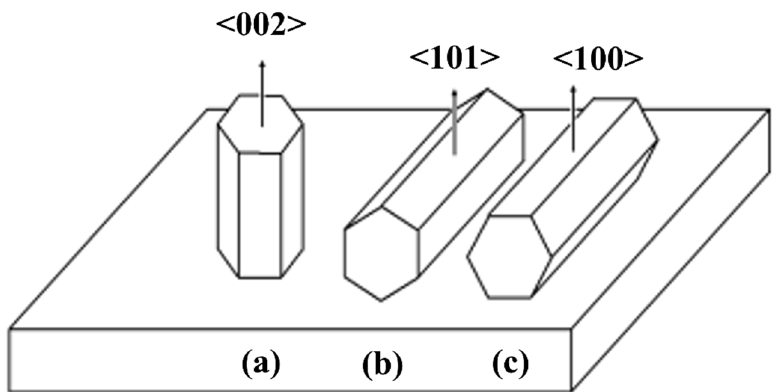
Figure 7. Schematic diagram of the relationship between microstructure and crystal growth orientation of ZnO: ( a ) a columned structure of c ‐ axis growth perpendicular to the substrate, ( b ) entation of ZnO: ( a ) a columned structure of c-axis growth perpendicular to the substrate, ( b ) a a pyramid ‐ like structure of c ‐ axis growth parallel to the substrate, and ( c ) polygon structure of pyramid-like structure of c-axis growth parallel to the substrate, and ( c ) polygon structure of c-axis c ‐ axis growth parallel to the substrate [26]. growth parallel to the substrate